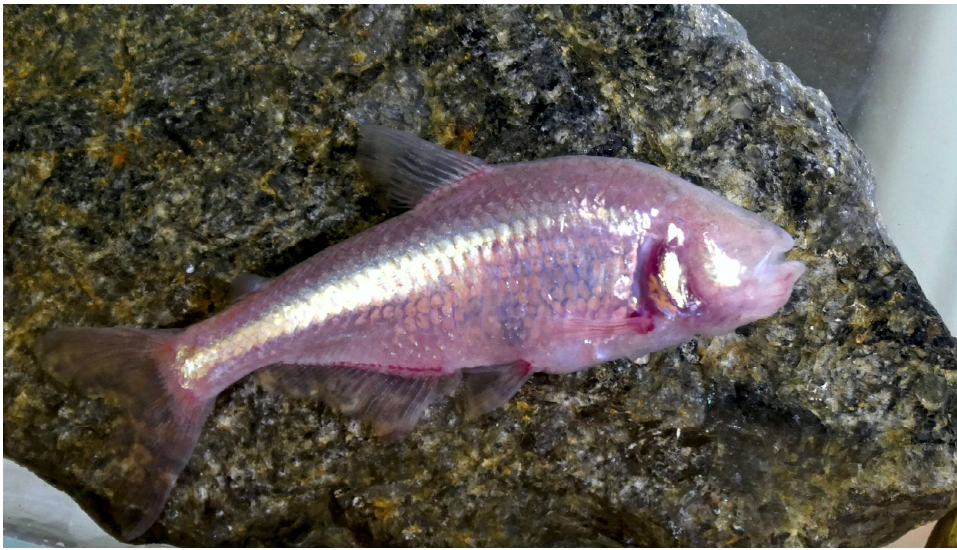
Figure 1. Blind Mexican tetra Astyanax mexicanus